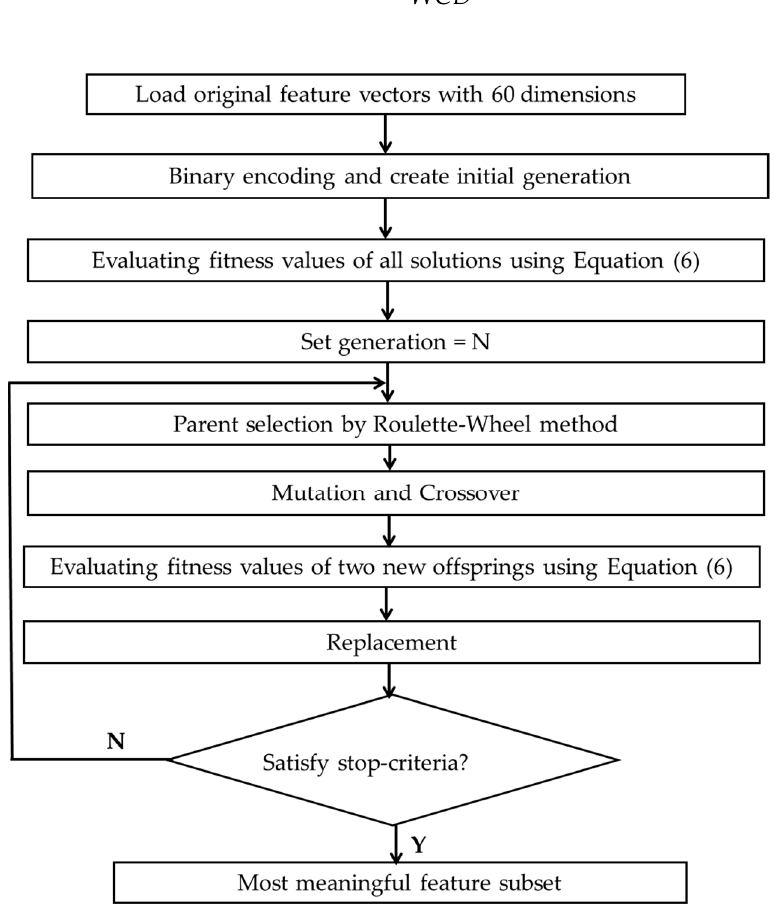
Figure 6. The flow diagram of the genetic algorithm (GA) procedure for finding an optimal IMF set.